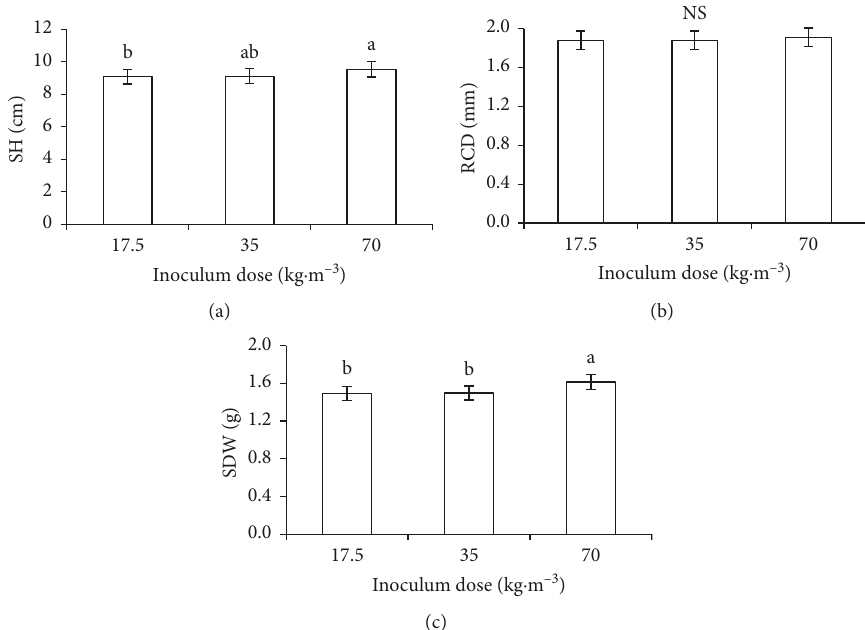
Figure 4: (a) Shoot height (SH), (b) root collar diameter (RCD), and (c) shoot dry weight (SDW) of P. maximinoi seedlings as a function of inoculum dose. Bars indicate standard error. Columns with different letters indicate significant difference ( P multiple range test of Duncan.